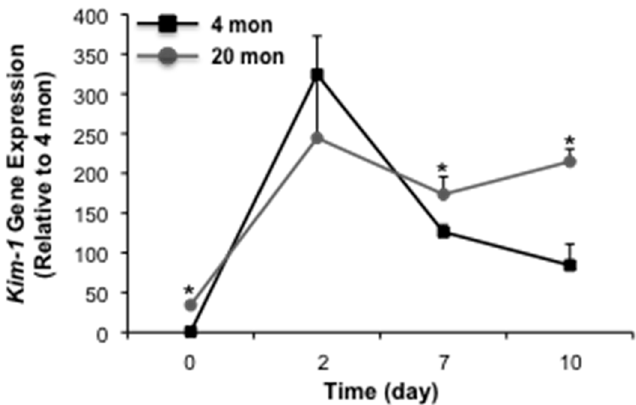
Figure 2. The impact of aging on mercuric chloride-induced Kim-1 gene expression. Twenty mon old rats were challenged with mercuric chloride and Kim-1 gene expression was assessed 2, 7 or 10 day following injury. Each data point represents the mean + SEM of 3–4 animals, * indicates a significant difference from young control (4 mon).